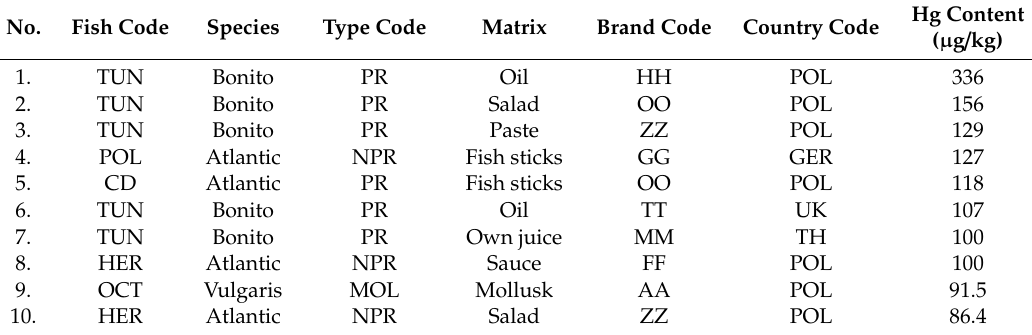
Table 3. A summary of the highest mean values of mercury content in the studied samples. Values